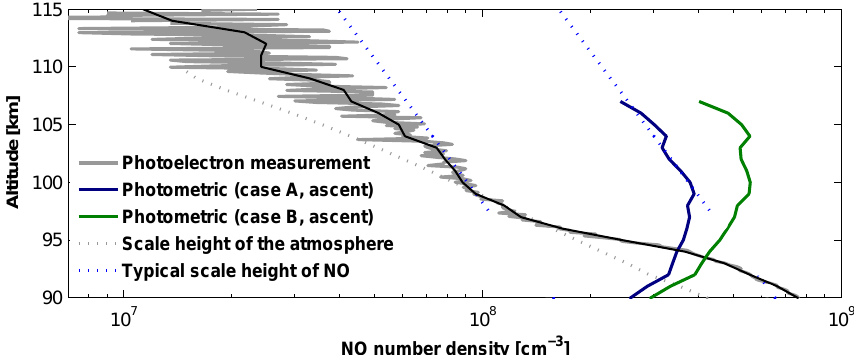
Fig. 6. The solid grey profile is the NO concentration inferred from the photoelectron measurement by the ECOMA detector (the solid black profile is the 1km interval averaged inferred NO concentration). The solid blue and green profiles are the “case A” and “case B” NO concentrations inferred from the photometric study on the ascent part of the flight, respectively. The dotted grey line is the scaled atmospheric density showing the decrease of the neutral atmosphere with increasing altitude (scale height ∼ 5km around 105km) while the two dotted blue lines show the typical decrease of the NO concentration with altitude above the peak (typical scale height ∼